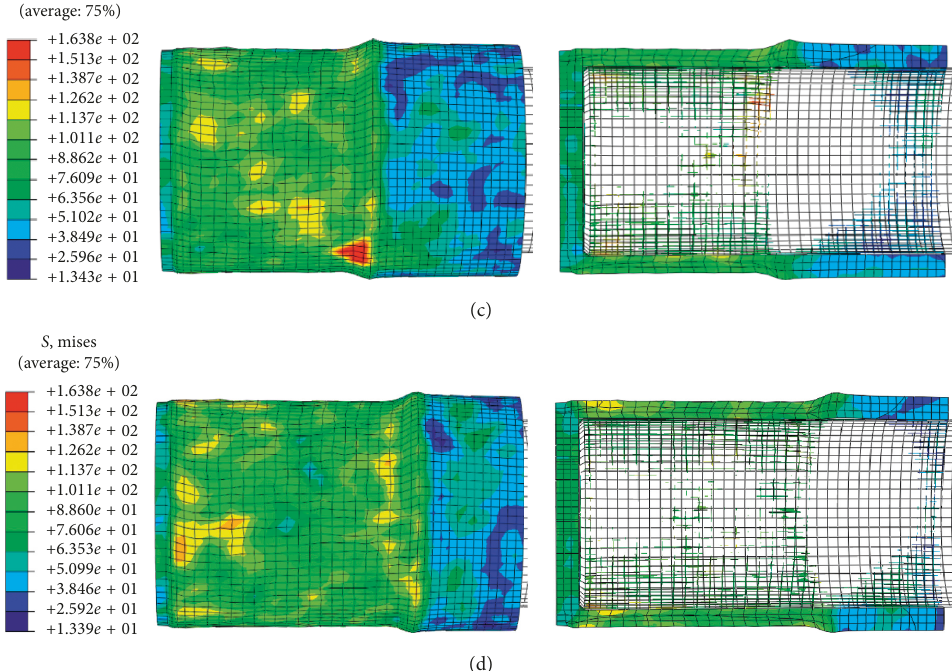
Figure 9: Second-pass equivalent stress distribution. (a) 25%. (b) 50%. (c) 75%. (d)